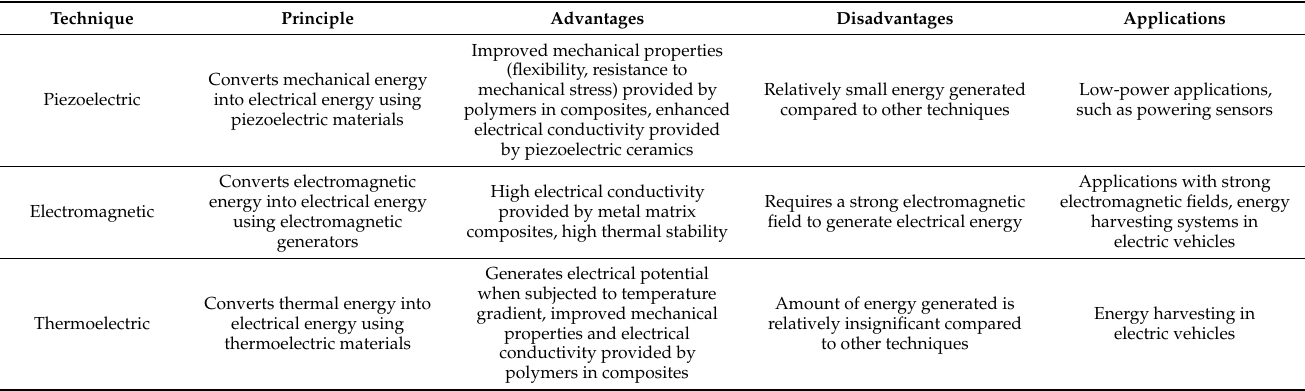
Table 2. Comparison of Energy Harvesting